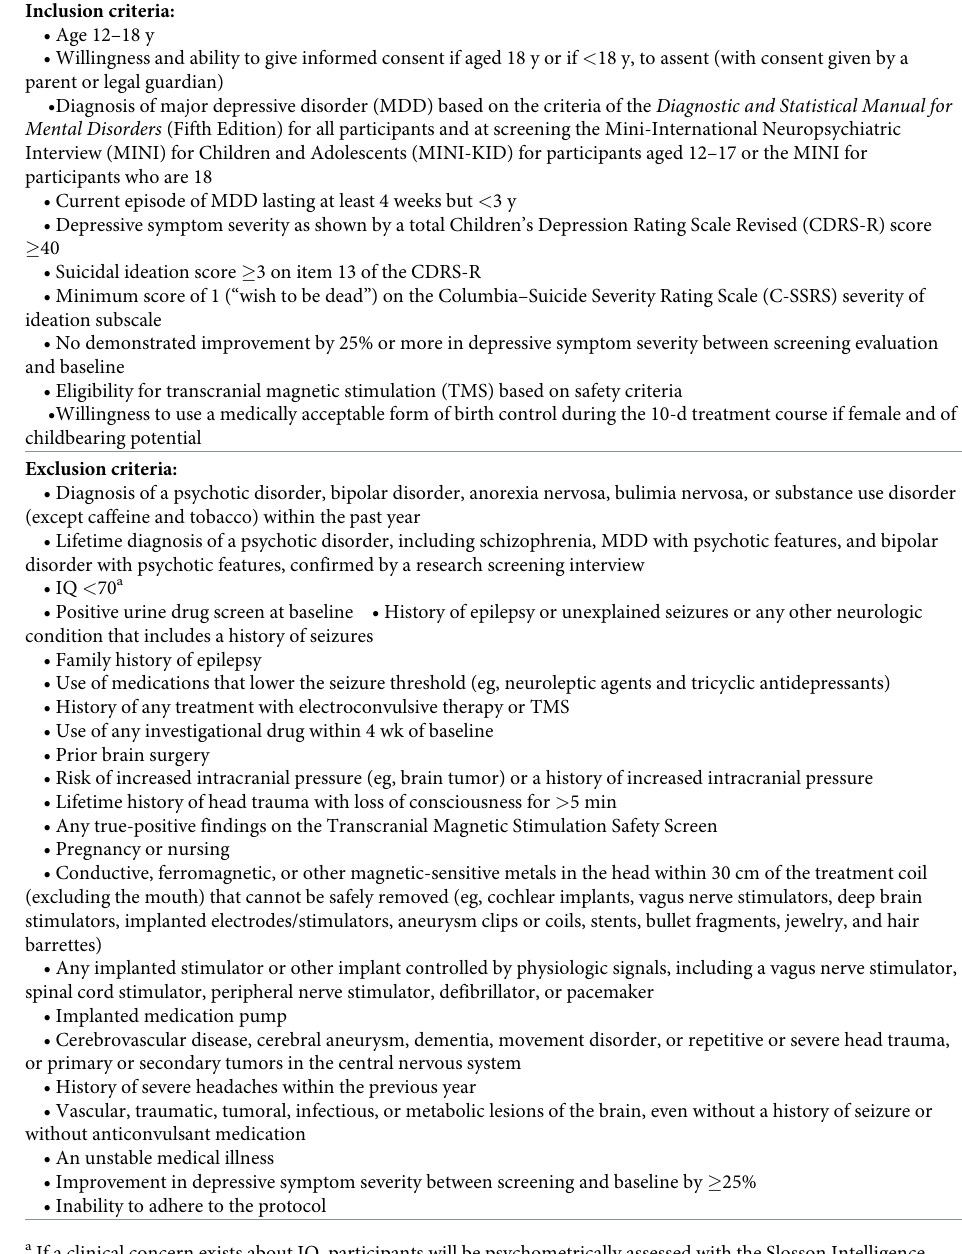
Table 1. Inclusion and exclusion